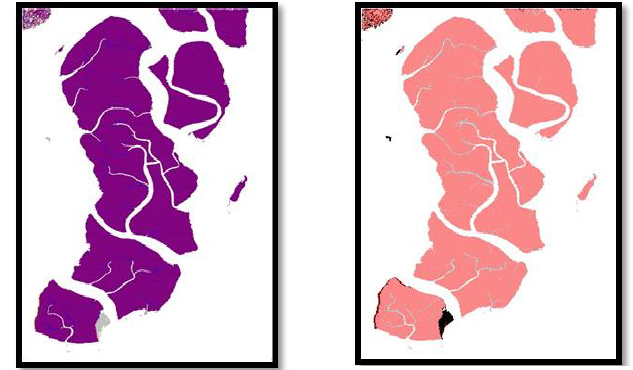
Figure 9: SLAMM output with SLR 1 meter and subsidence 4mm/year